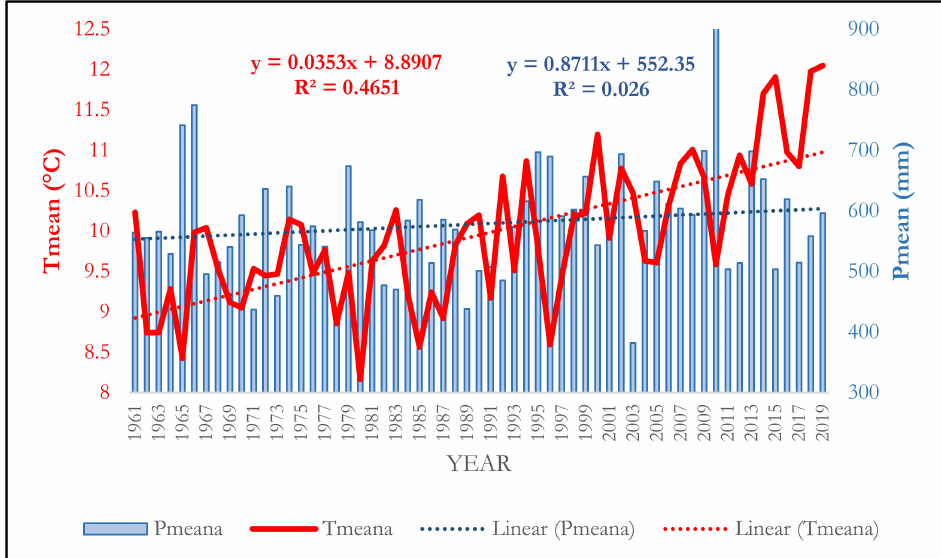
Figure 3. Tmean a and Pmean a during study period in investigated